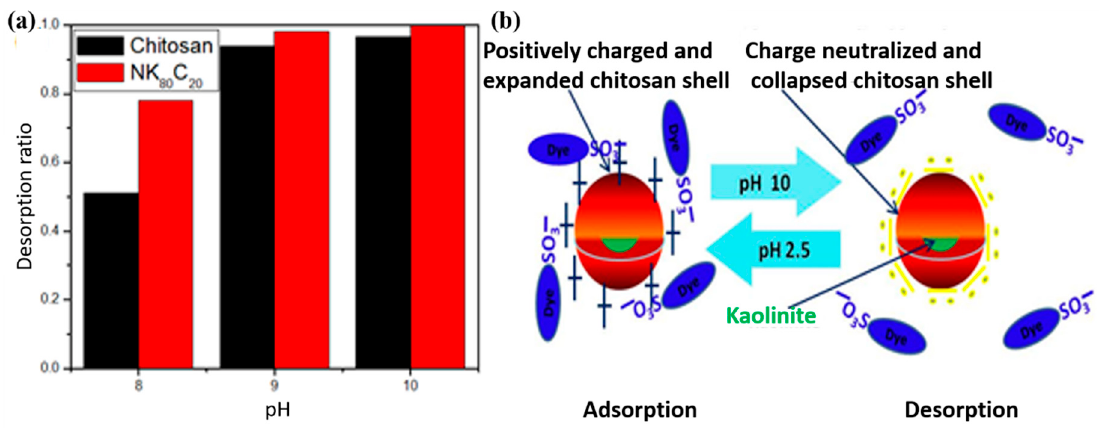
Figure 4. ( a ) Bar diagram of desorption ratio vs. pH and ( b ) schematic illustration for the adsorption– adsorption–desorption mechanism of desorption mechanism of RR.